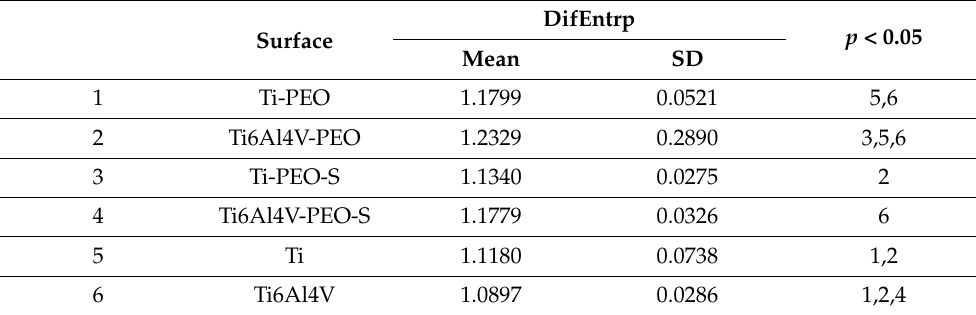
difference entropy (DifEntrp), standard deviation